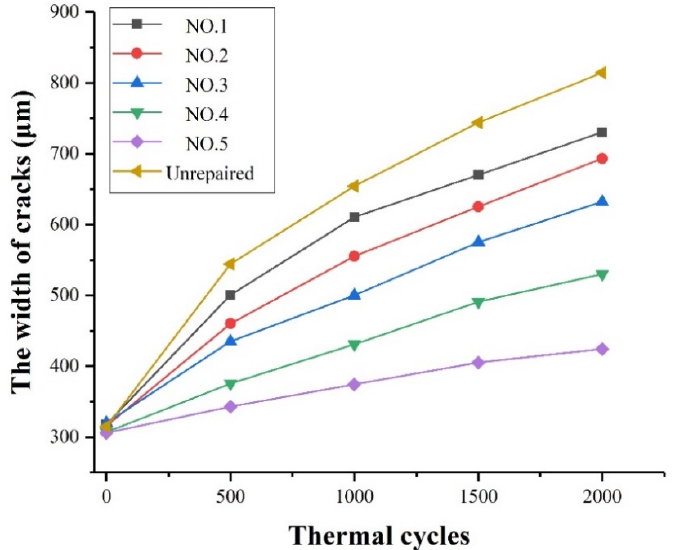
Figure 14. The W-N curve (W is the width of the thermal crack; N is the number of thermal cycles).